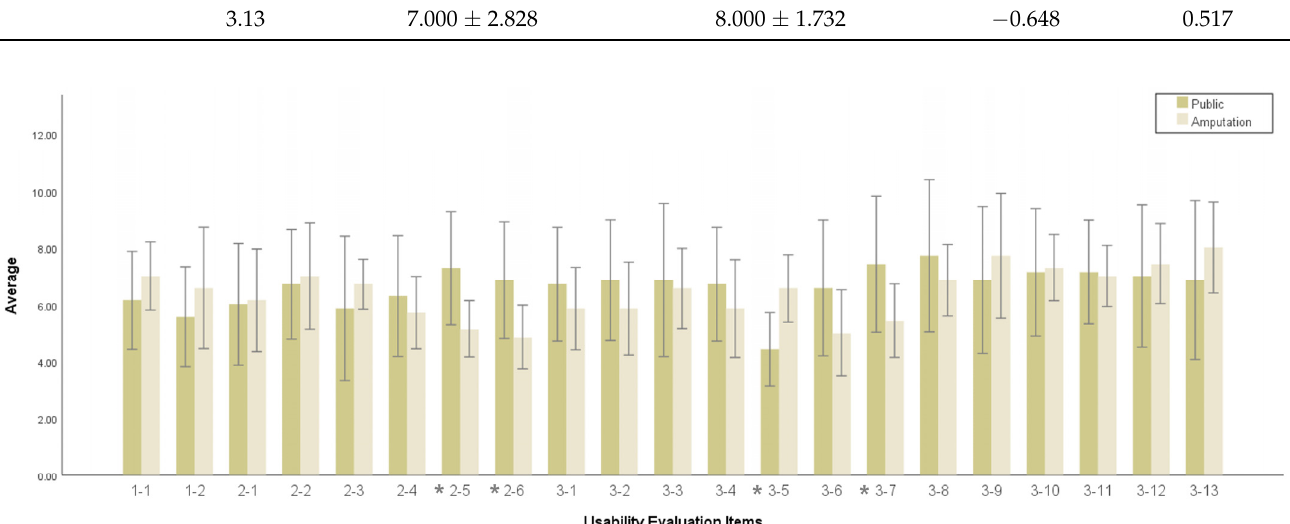
Figure 12. Evaluation Results and Scores by Amputated Status (*: p <